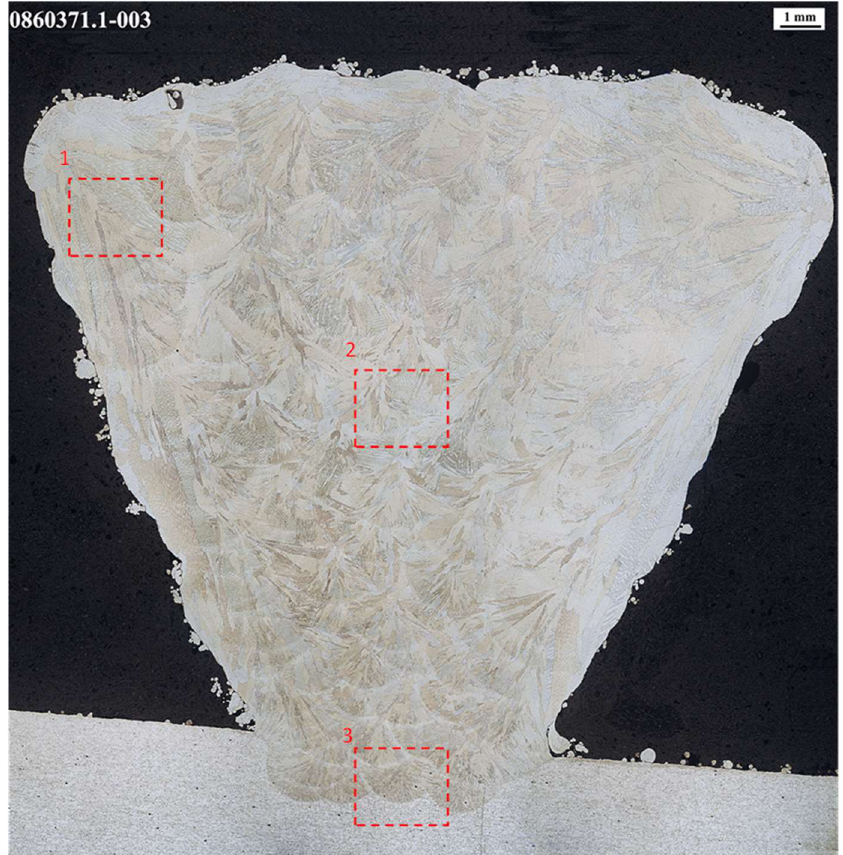
Figure 4. Control structure. As deposited. Zone 1: edge of the cross-section; Zone 2: core of the cross-section; Zone 3: first deposited layer and dilution zone with the substrate.